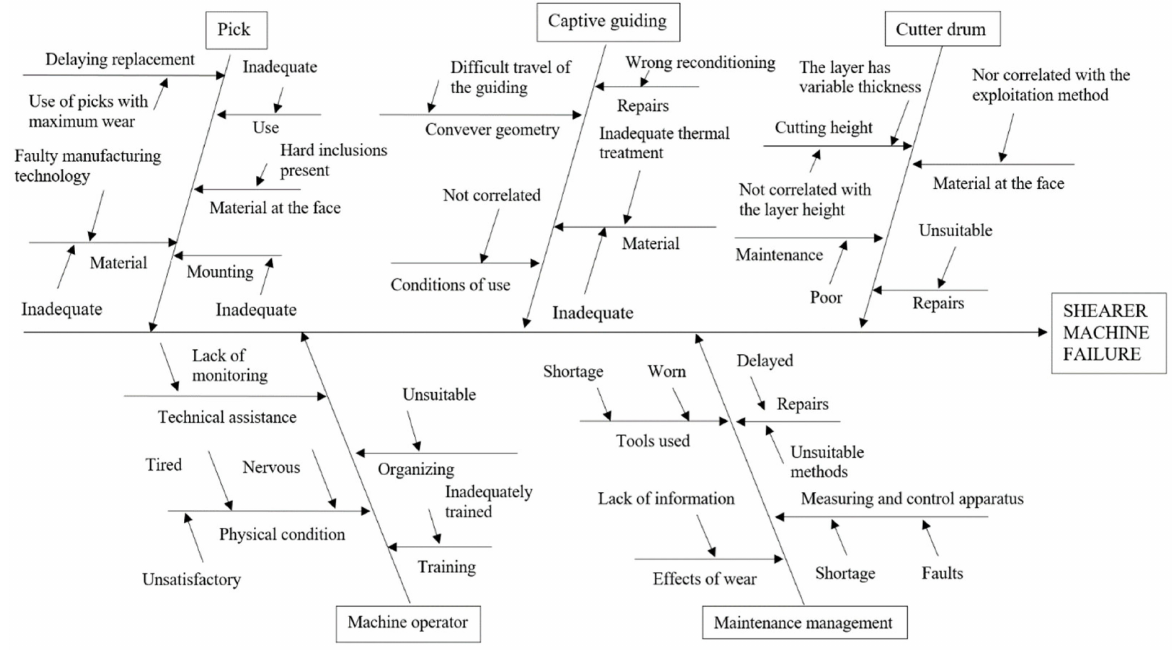
Figure 6. Ishikawa diagram regarding KSW-460NE shearer machine